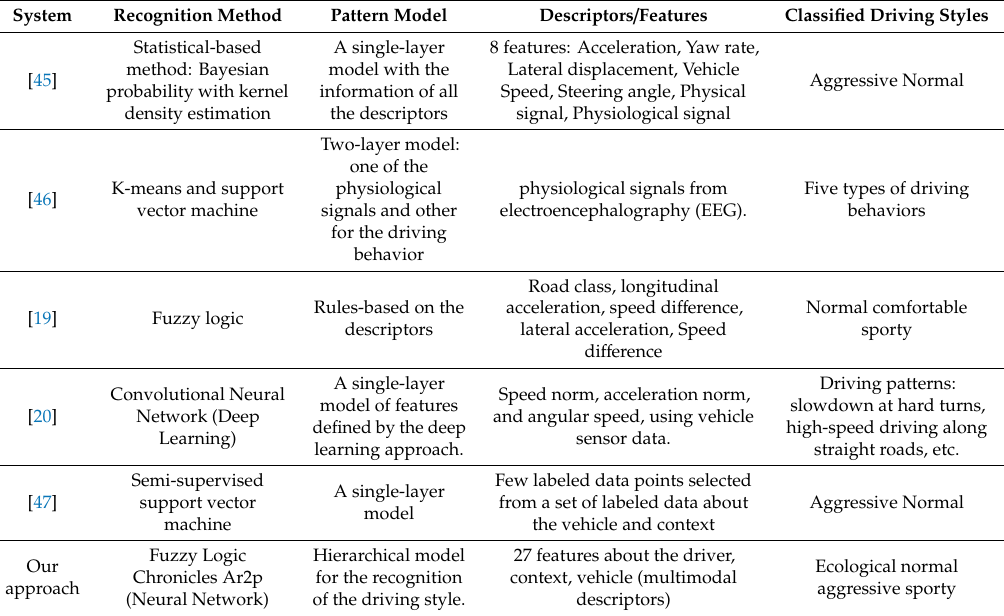
Table 18. Comparison with other